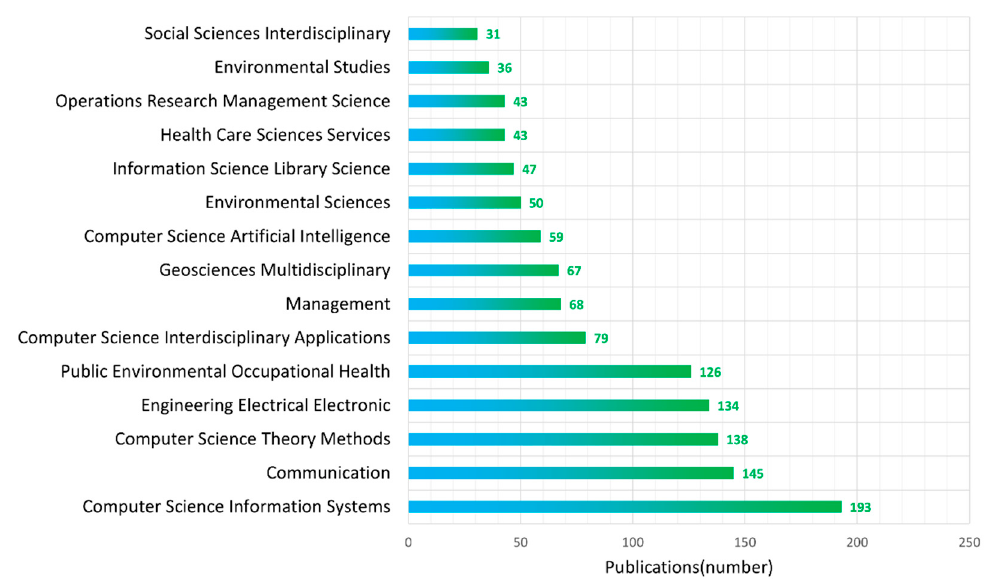
Figure 3. Distributions of popular disciplines. The number of publications from the top 15 disciplines is shown.